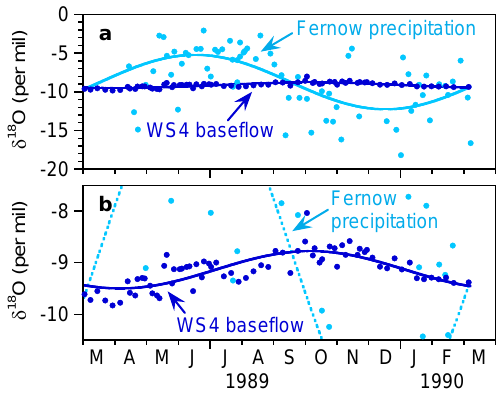
Figure 1. Seasonal cycles in δ 18 O in precipitation and baseflow at catchment WS4, Fernow Experimental Forest, West Virginia, USA (DeWalle et al., 1997). Both panels show the same data; the axes of (b) are expanded to more clearly show the seasonal cycle in baseflow. Sinusoidal cycles are fitted by iteratively reweighted least squares regression (IRLS), a robust fitting technique that limits the influence of